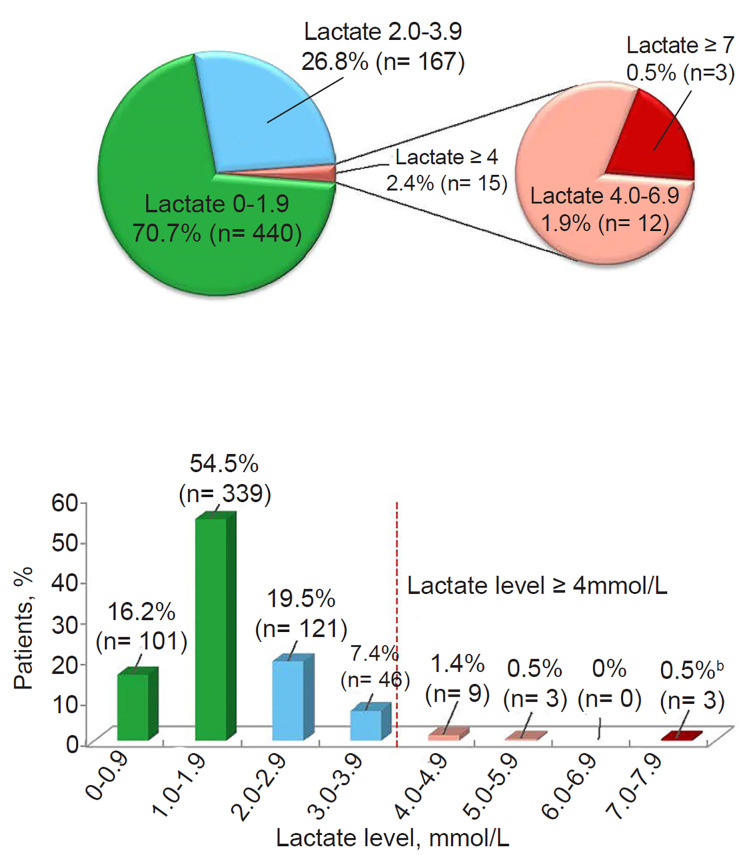
Baseline lactate levels in DUR001-303 (N = 622).aa622 ITT patients had available baseline plasma lactate levels (normal range, 0.5–2.2 mmol/L). Figure includes 20 patients with lactate = 2.0 mmol/L.bCase of necrotizing fasciitis in DUR001-303 (lactate = 7 mmol/L).ITT, intention-to-treat; mmol/L, millimoles per liter.